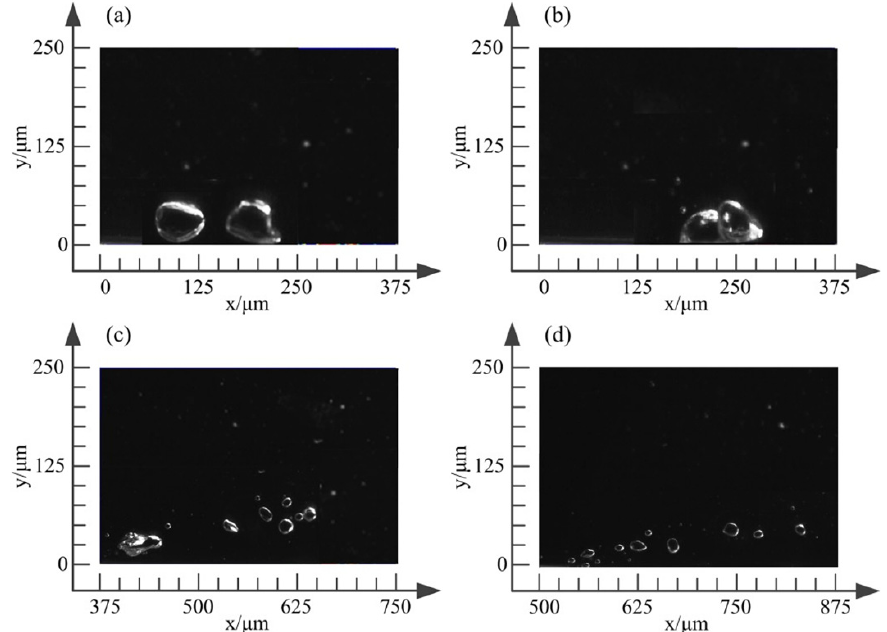
Figure 21. Experimental results of double bubbles bursting on the wall at different times (a) t = 3 μ s, (b) t = 60 μ s, (c) t = 120 μ s, (d) t = 200 μ s.